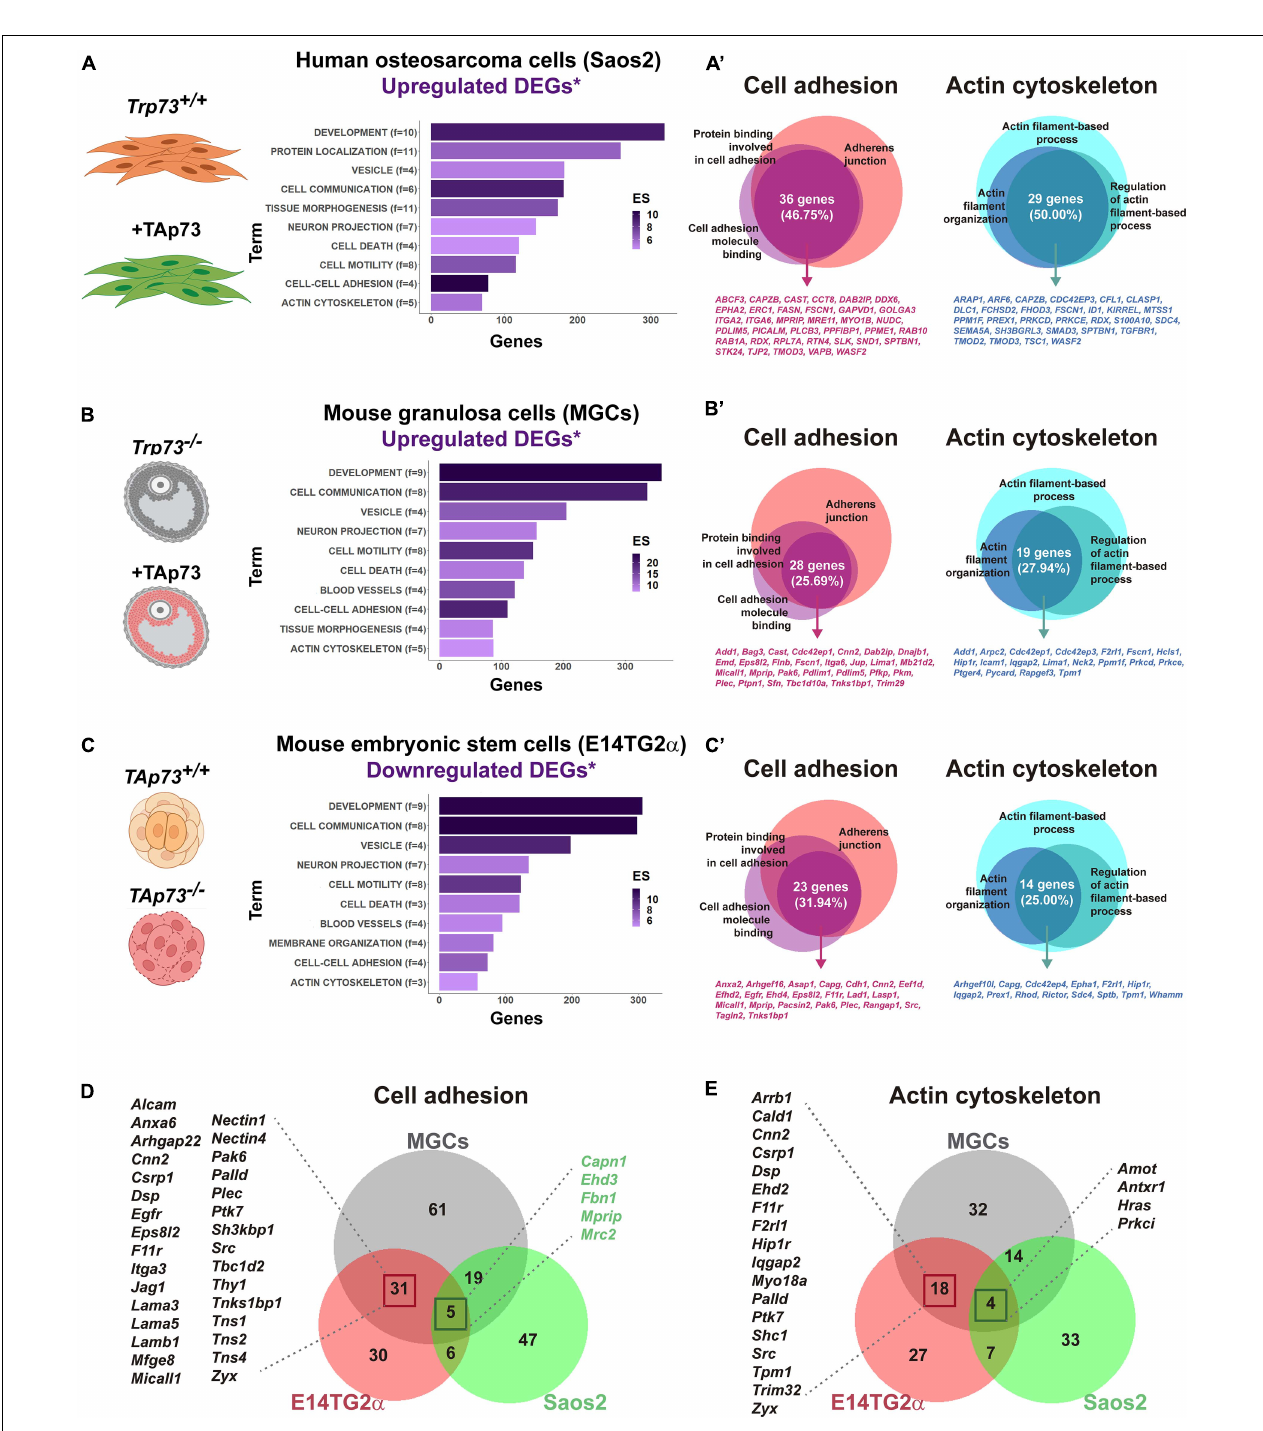
FIGURE 3 | p73 is a central hub of cellular adhesion and cellular cytoskeleton dynamics. For the indicated cell models, putative TAp73 target genes (DEGs*) were obtained by comparison of differentially expressed genes (DEGs) derived from RNA-seq studies with candidate genes containing p73 binding peaks (*) according to ChIP-seq studies by Koeppel et al. (2011), Marshall et al. (2016), and Santos Guasch et al. (2018). A total number of 736 genes for Saos-2-Tet-On cells, 679 genes for MGCs, and 709 genes for E14-TAp73KO were analyzed with DAVID Bioinformatics Resources 6.8. Functional annotation clustering was performed and enriched biological GO terms for Saos2-Tet-On cells (A) , MGCs (B) and E14-TAp73KO (C) are represented. Overlapping genes within GO terms related to “Cell-cell adhesion” and “Actin cytoskeleton” were furthered identified and represented for the three cell models (A’–C’) . Comparison of the whole list of DEGs assigned to these clusters between the three cell models is shown (D,E) . Publicly available datasets were analyzed in this study and can be found here: GSE15780, PRJNA310161; PRJNA437755. The pictures were created with BioRender.com.